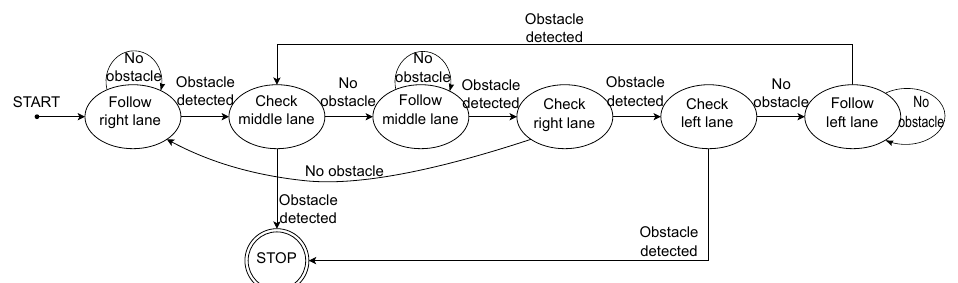
Figure 5. Scheme of robot’s evolution overtime.